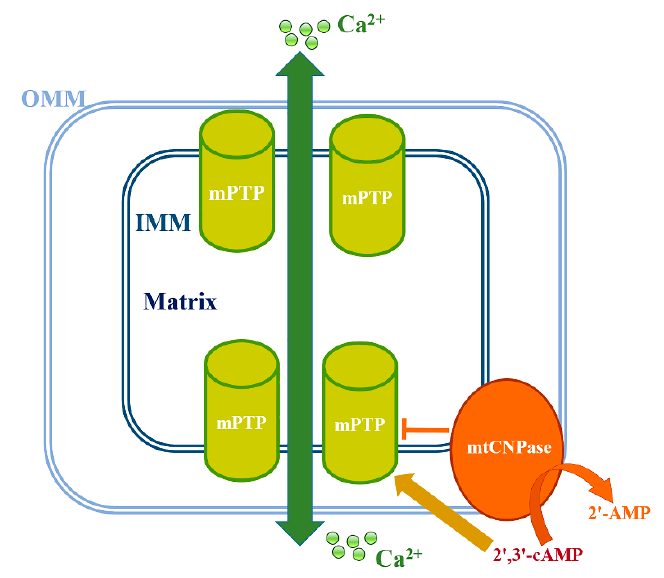
Figure 2. Schematic representation of the role of mtCNPase in mPTP function.